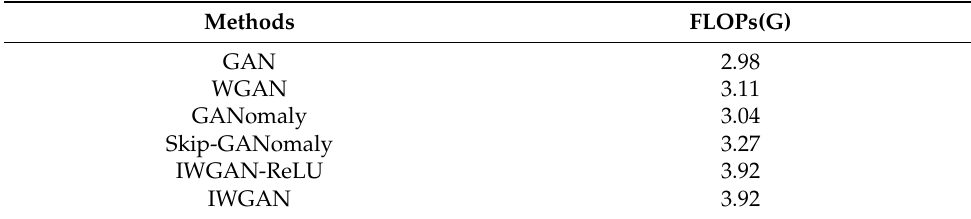
Table 5. The FLOPs of each